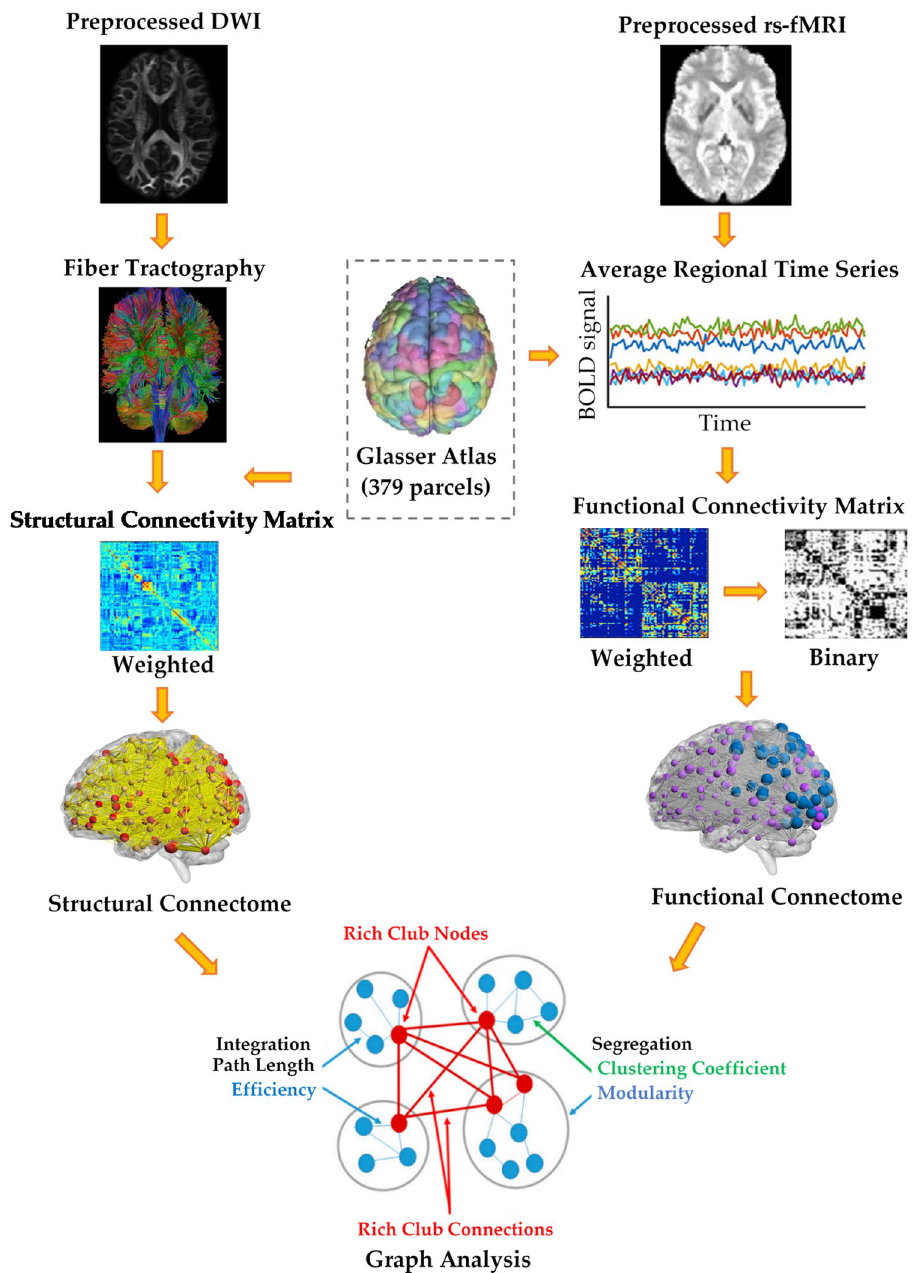
Figure 1. Processing pipeline for brain structural and functional Network Analysis. A structural connectome was constructed for each individual using fiber tractography and a parcellation scheme. A functional connectome was also constructed for each individual by calculating the pairwise Pearson’s correlation coefficient of the average time courses of 379 regions. A graph-theoretical analysis was then performed to investigate the topological properties and rich-club organization of the structural and functional brain networks in both healthy controls and cannabis